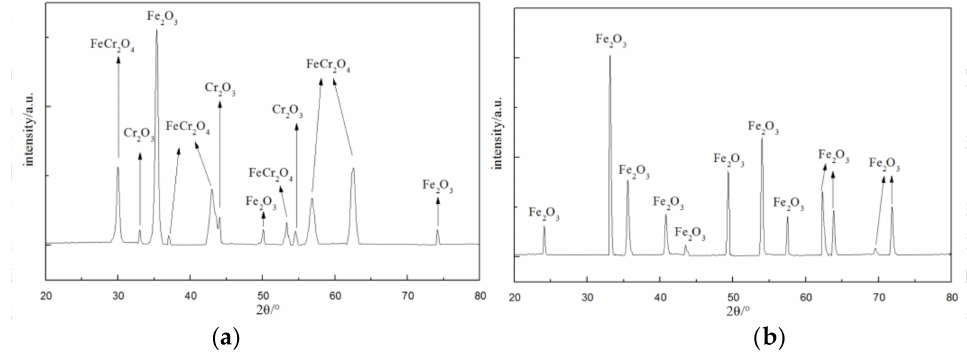
Figure 3. ( a ) XRD analysis result of the Super304H sample’s surface; ( b ) XRD analysis result of the HR3C sample’